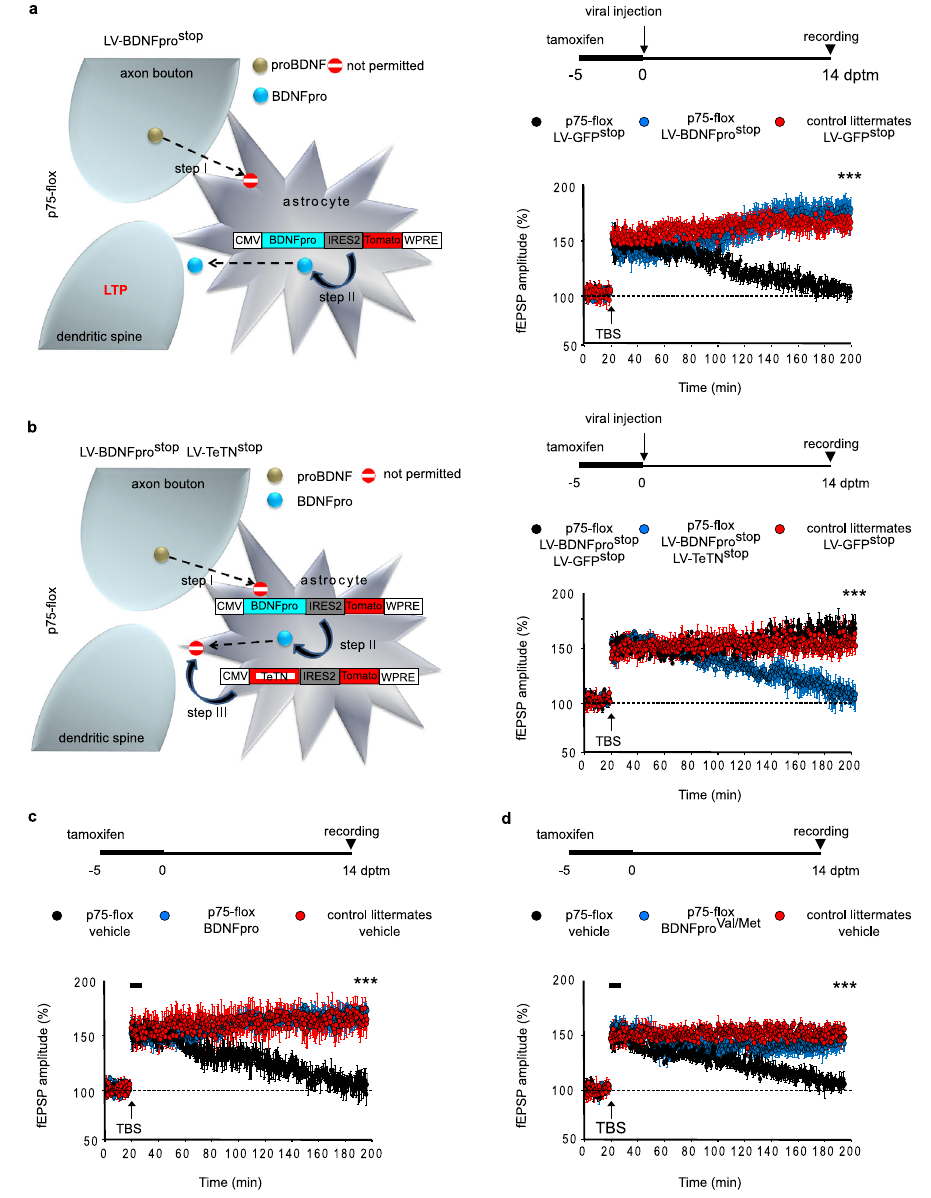
Fig. 5 astrocytic BDNFpro secretion rescues LTP de fi cit in p75- fl ox mice. a Schematic representation of the experimental design. Step I, deletion of p75 NTR in astrocytes from tamoxifen-treated p75- fl ox mice precludes proBDNF transfer from neurons to astrocyte following TBS. Step II, LV-BDNFpro stop transduction replaces BDNFpro in astrocytes. Schematic representation of the experimental paradigms (right); mice were treated with tamoxifen ( − 5 to 0), injected with lentiviruses the last day of tamoxifen treatment (0 dptm) and fi nally recorded (14 dptm). LTP evoked in slices from p75- fl ox mice and control littermates injected with LV-GFP stop or LV-BDNFpro stop is shown. *** p < 0.001 (unpaired t -test) (p75- fl ox/LV-GFP stop 102.00 ± 1.85%, p75- fl ox/ LV-BDNFpro stop 177.41 ± 10.74% and control littermates/LV-GFP stop 165.27 ± 2.24% fEPSP 180 min from TBS; n = 10 slices, 6 mice for p75- fl ox/LV- GFP stop ; n = 9 slices, 6 mice for p75- fl ox/LV-BDNFpro stop ; n = 6 slices, 4 mice for control littermates/LV-GFP stop ). b Schematic representation of